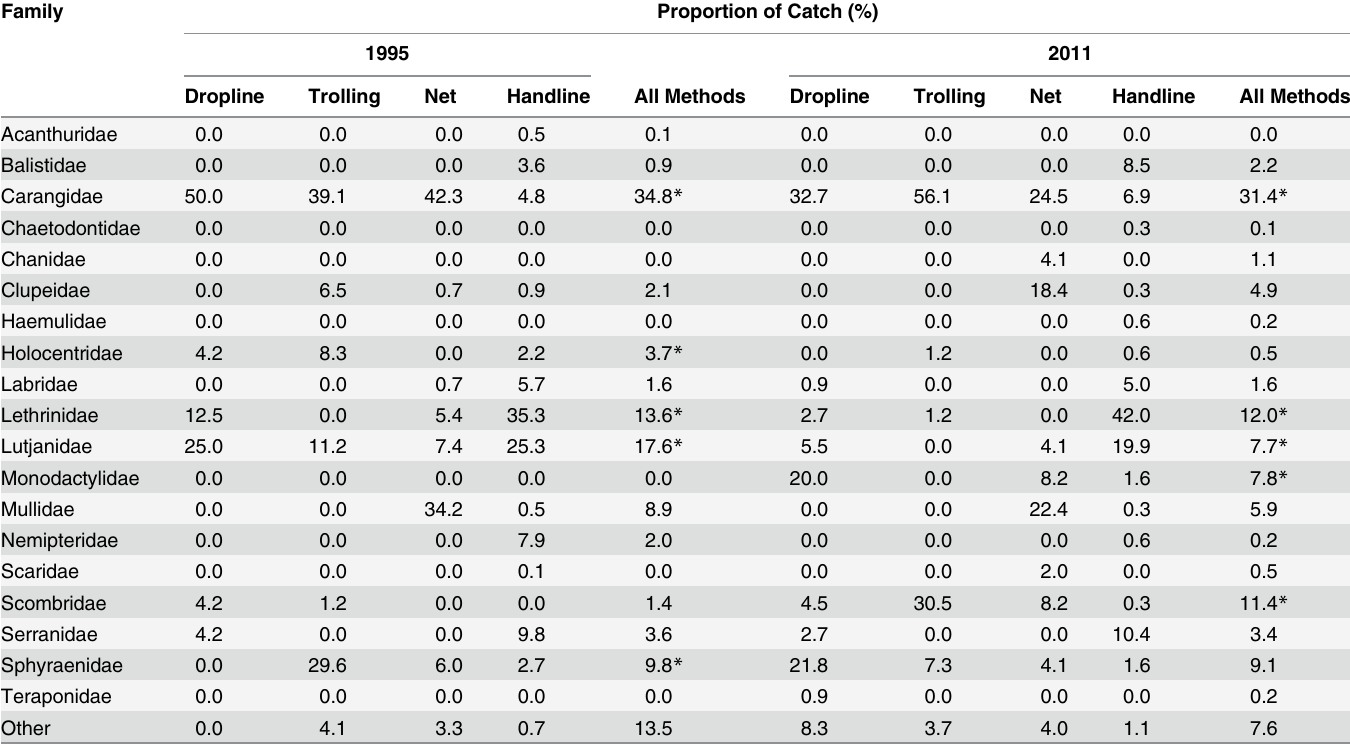
Table 2. Proportion of fish catch (abundance) by family and fishing methods for 1995 and 2011 within the Roviana lagoon study area.